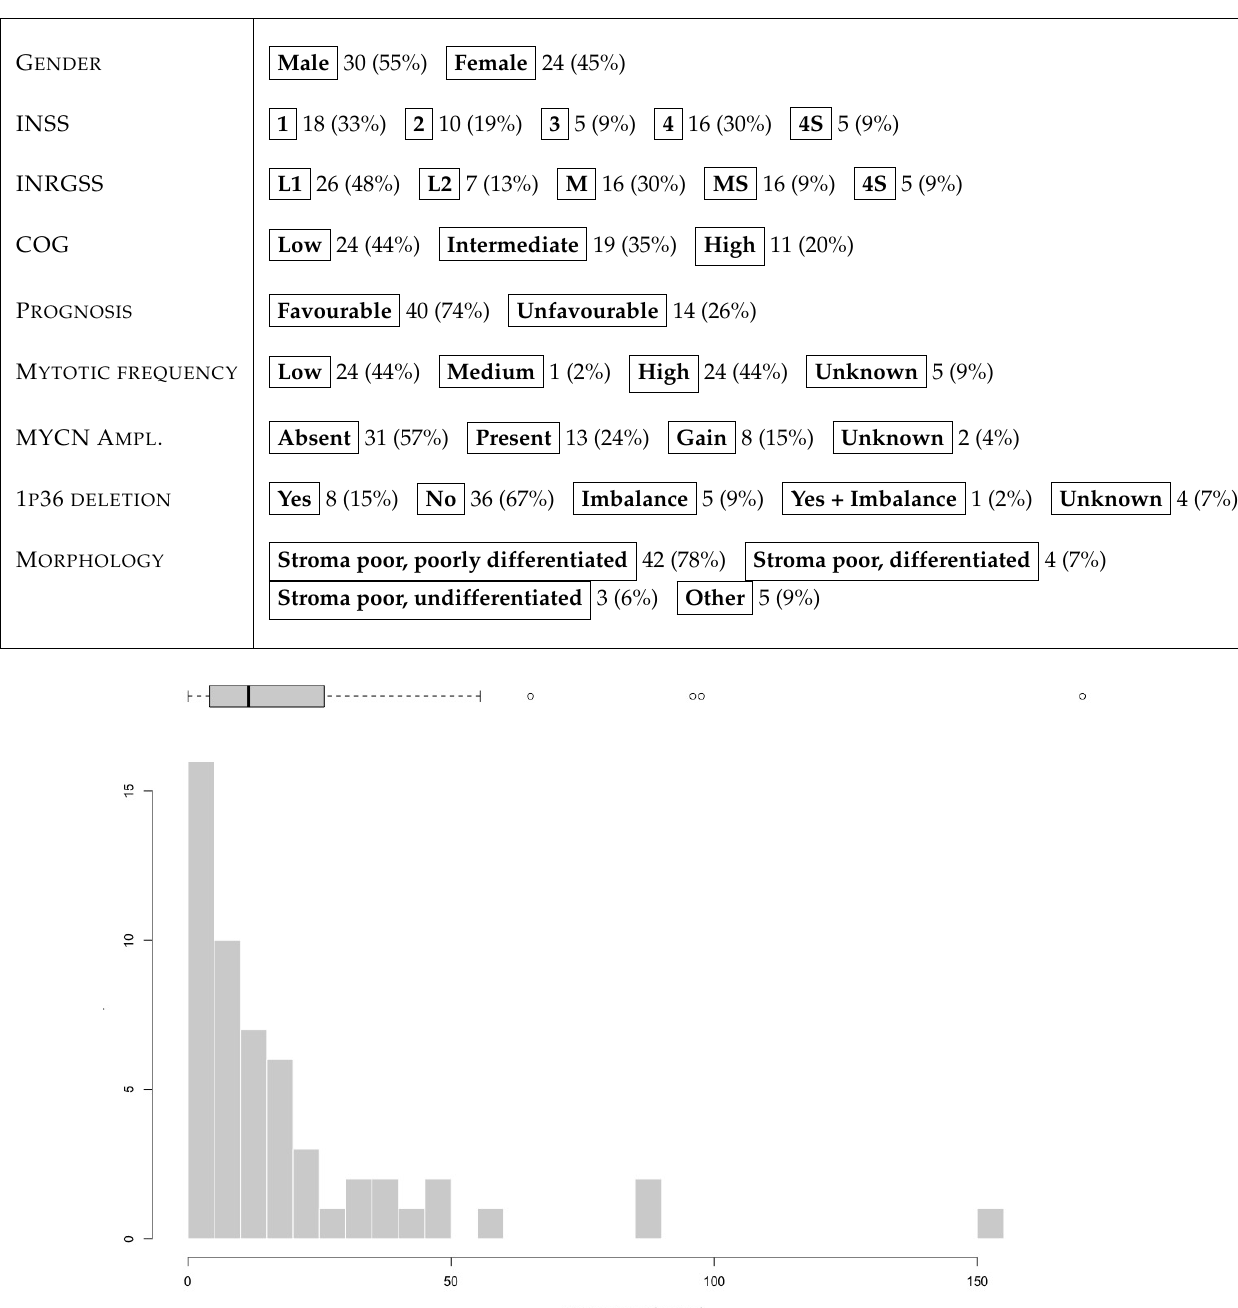
Figure 19. Summary of clinical features and age distribution at diagnosis (month) for the 54 patients of the NeSTBG